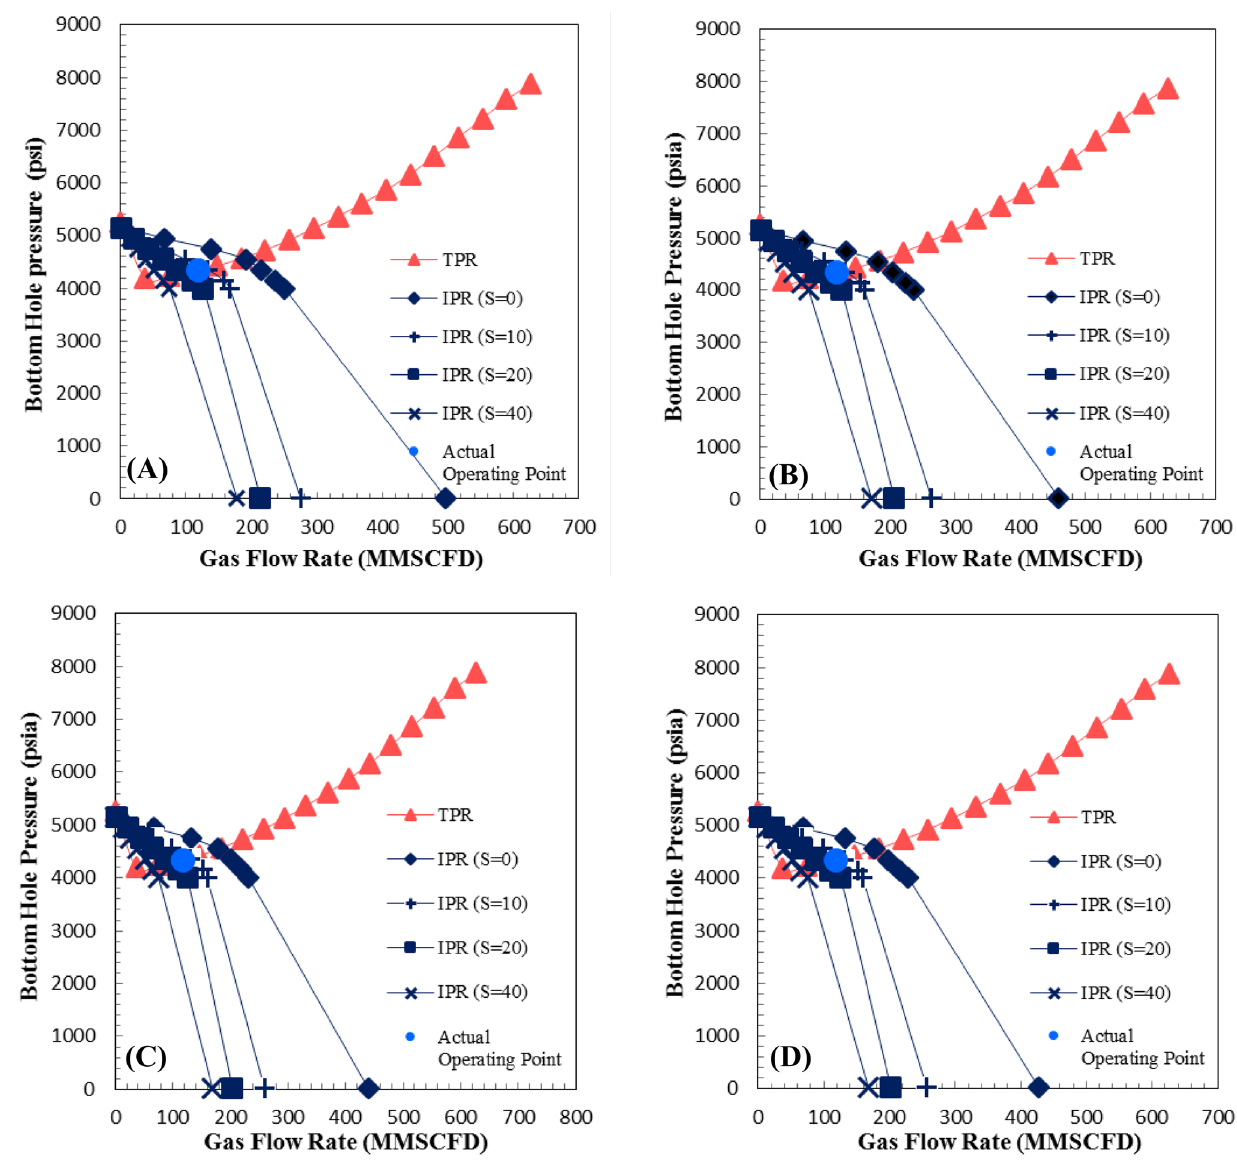
Fig. 11 Nodal analysis for simulated cases in a group # 1, b group # 2, c group # 3 and d group #